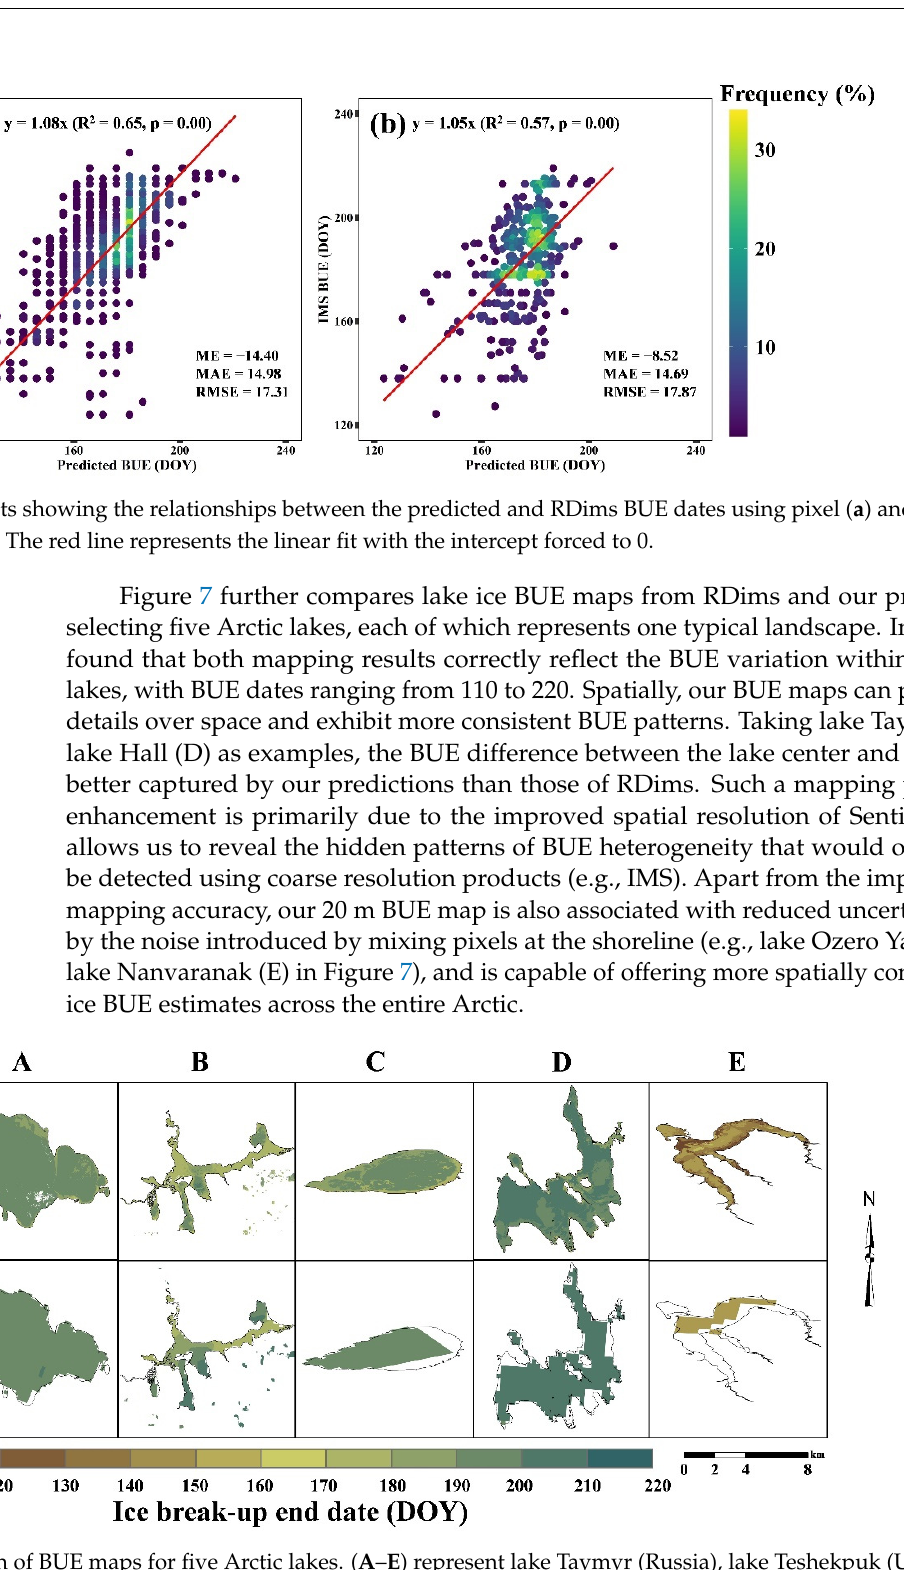
Figure 7. Comparison of BUE maps for five Arctic lakes. ( A – E ) represent lake Taymyr (Russia), lake Teshekpuk (U.S.), lake Ozero Yarato (Russia), lake Hall (Canada), and lake Nanvaranak (U.S.), respectively.